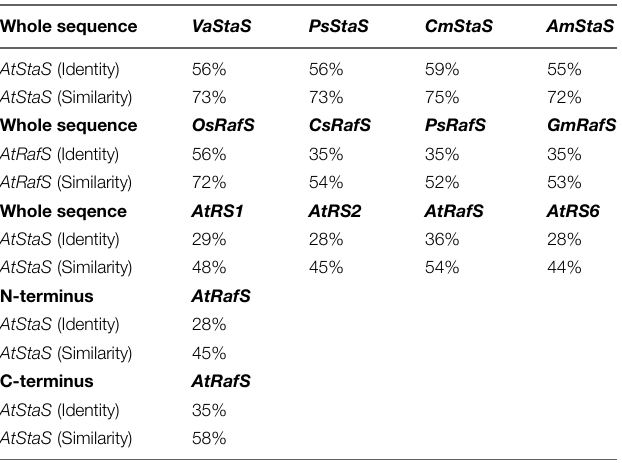
TABLE 1 | Identity and similarity calculation of stachyose synthase (StaS) and raffinose synthase (RafS) amino acid sequences.